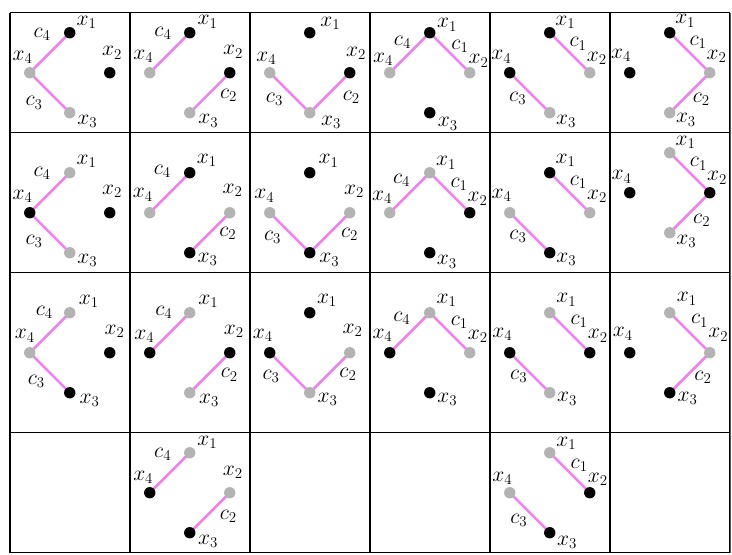
Figure 11: The collection of 2 -rooted forests for C 4 .